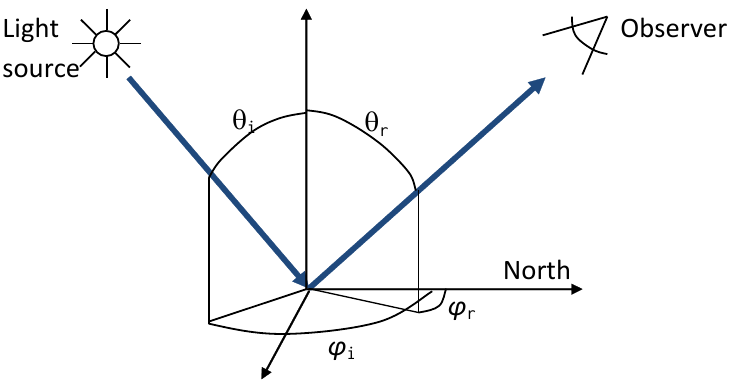
Figure 1. Bidirectional reflectance geometry.  reflected light,